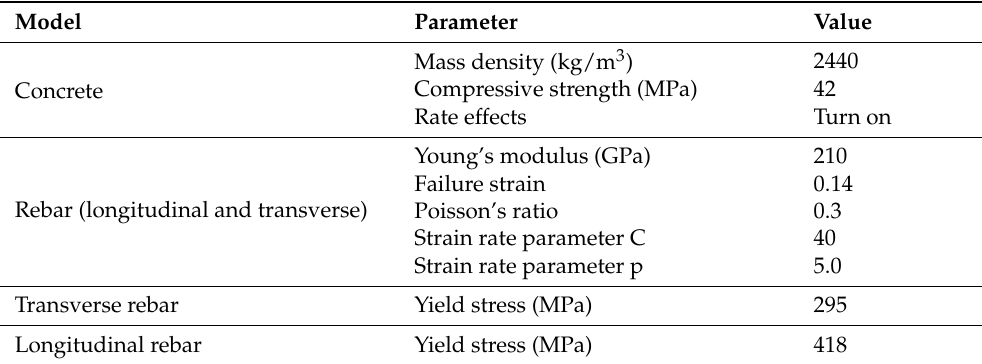
Table 2. Material properties used for I-shaped RC beams under impact loads.